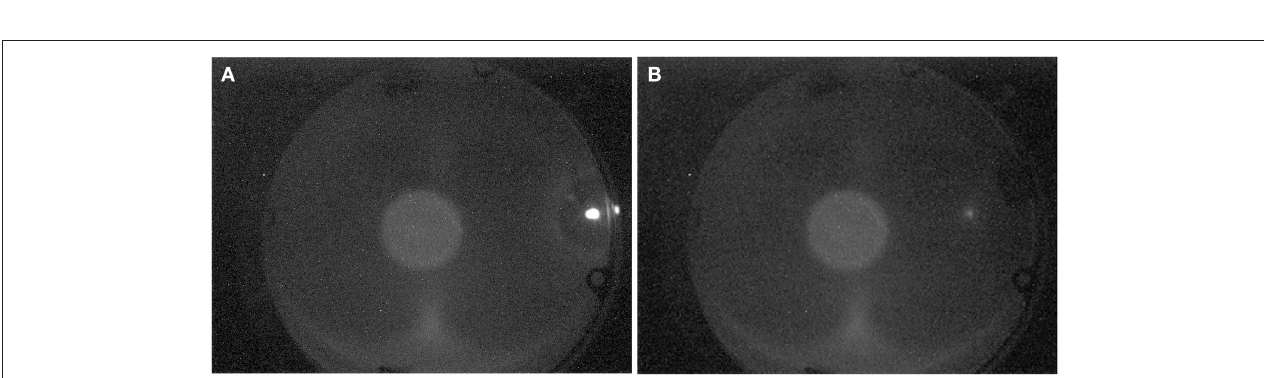
FIGURE 13 | (A) Position of the incoming electron beam with the cavity RF power turned off; (B) Position of the beam with cavity power turned on (the beam intensity was dimmer because only a small fraction of the incoming electrons were accelerated to the maximum